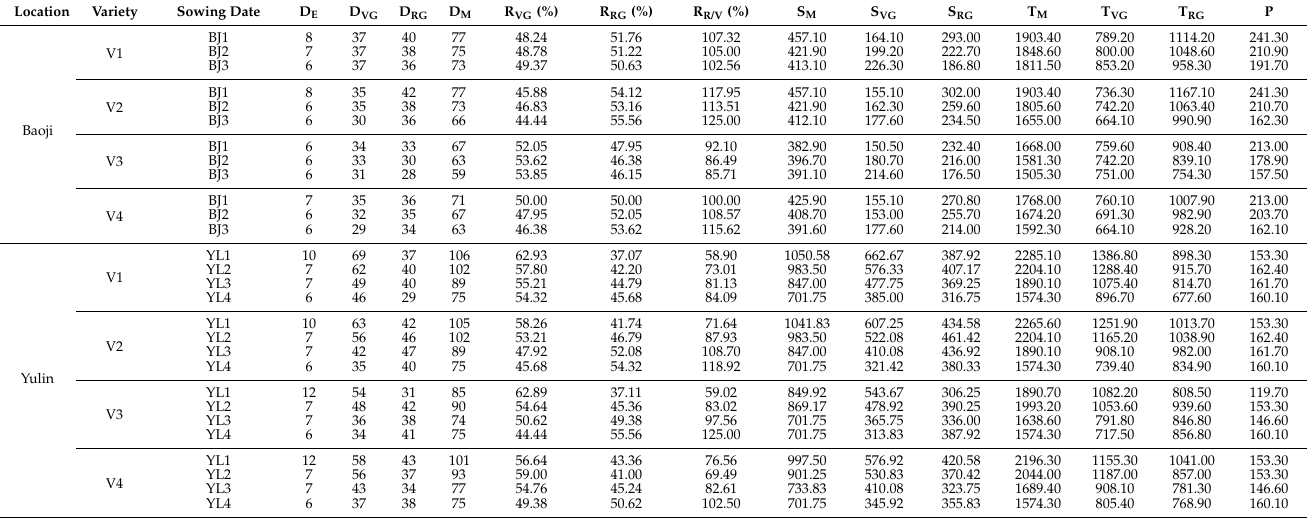
Table 4. The growth period of broomcorn millet and the meteorological factors under different sowing dates in the two